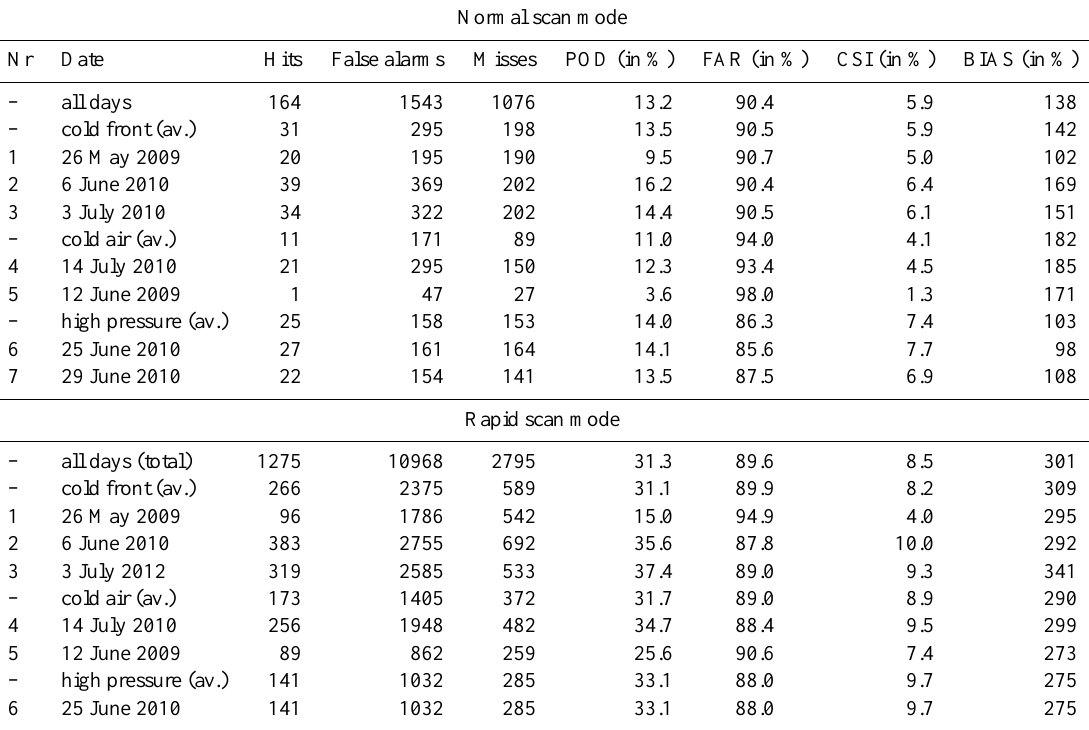
Table 5. Categorical variables and statistics under nighttime (00:00–07:00UTC, 17:00–00:00UTC) conditions for the new algorithm. Hits, misses and false alarms are given as absolute numbers; POD, FAR, CSI and BIAS are expressed as a percentage. For each of the synoptic classes the average (av.) values are